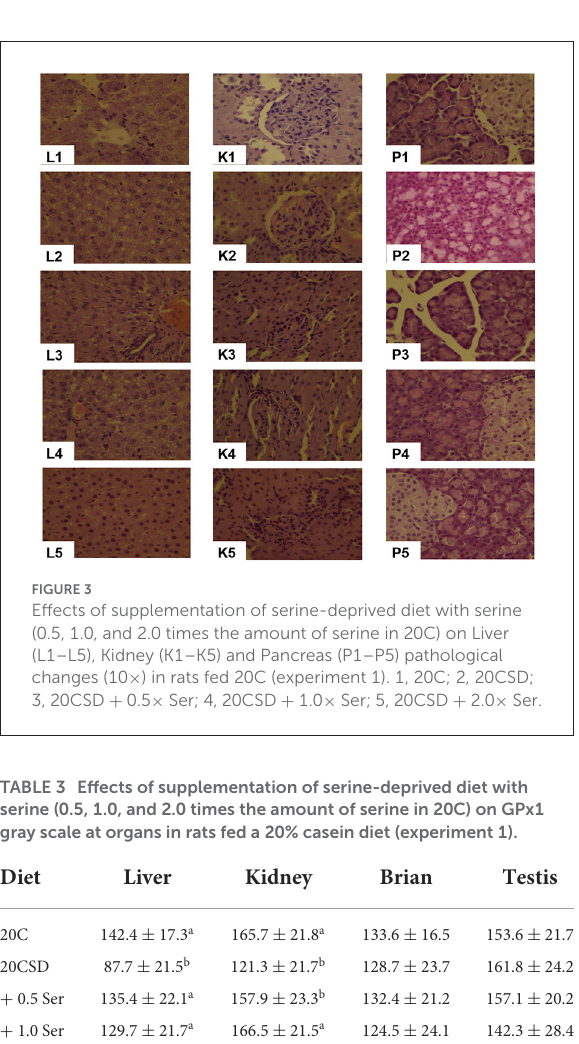
(Table 4). Plasma serine levels in 20CSD and 20CSD + NCT-503 were significantly lower than those in 20C and 20C + NCT- 503 ( P < 0.05; Figure 5A). Plasma Hcy was significantly higher in pregnant rats fed 20CSD (22.1 ± 7.8 µ mol/L) compared to those in 20C (4.31 ± 1.28 µ mol/L; P < 0.05). On the other hand, plasma Hcy were not affected by PHGDH inhibitor regardless of serine adequacy in the diet of pregnant rats (Figure 5B).